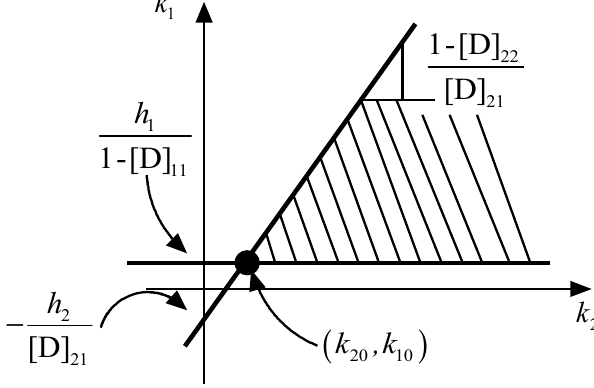
Figure 10. Graphical solution for k 1 and k 2